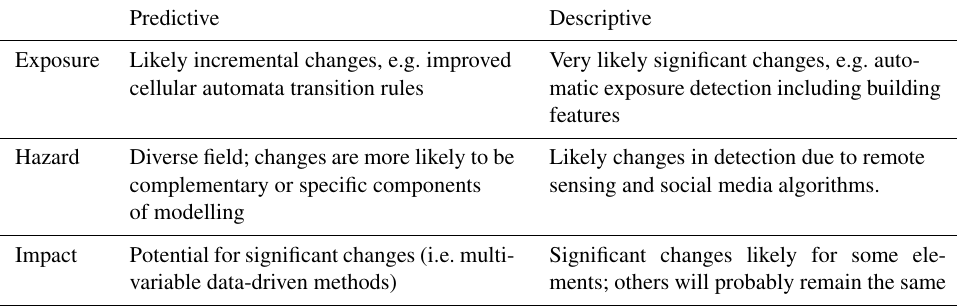
Very likely significant changes, e.g. auto- matic exposure detection including building features Likely changes in detection due to remote sensing and social media algorithms. Significant changes likely for some ele- ments; others will probably remain the